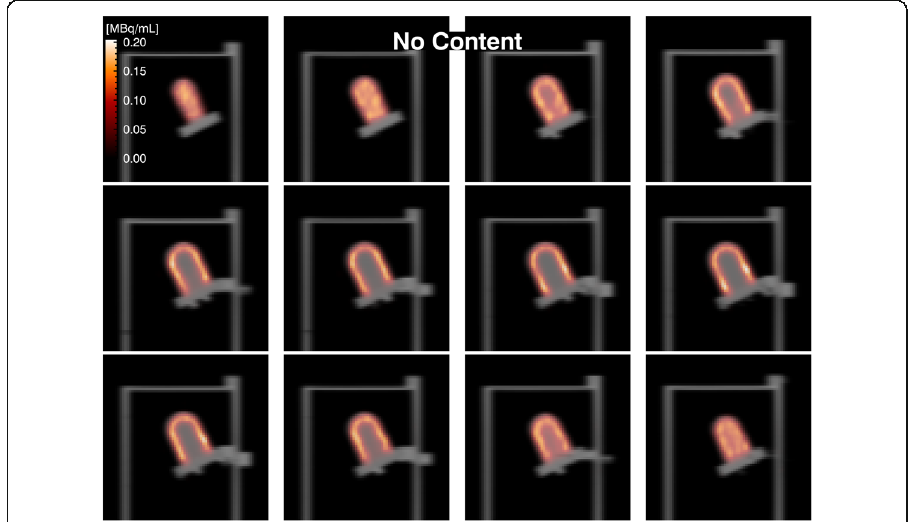
Fig. 6 Twelve consecutive SPECT slices (50 iterations) overlaid on the corresponding CT slices for a cardiac insert in an empty torso. The ventricle cavity was filled with water. The MCR and CT results are well registered with good contrast between the myocardium and